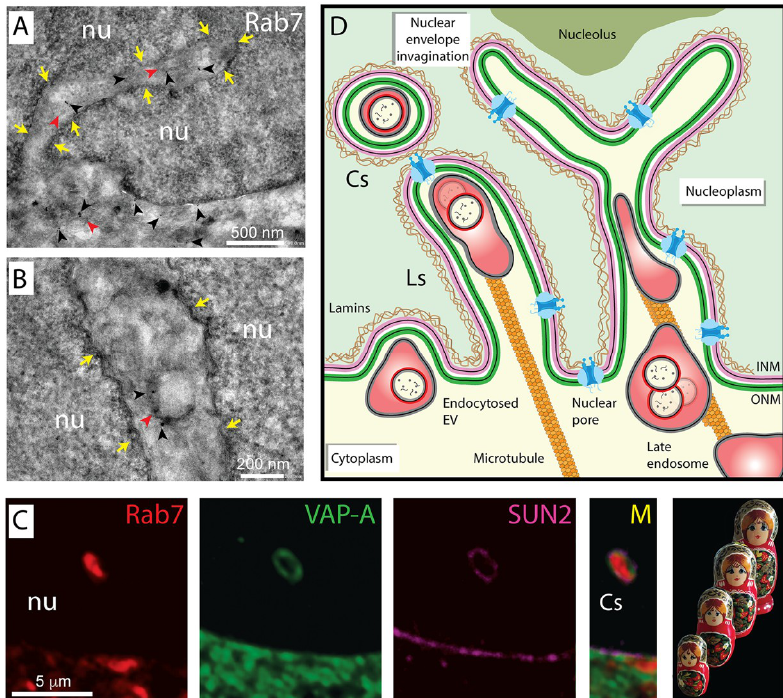
Figure 2. Entry of late endosomes into type II nuclear envelope invagination. ( A , B ) The presence of membrane-bound organelles (red arrowheads) in the nucleoplasmic reticulum (arrows) and cytoplasm of melanoma FEMX-I cells are observed by Rab7 immunogold labeling (black